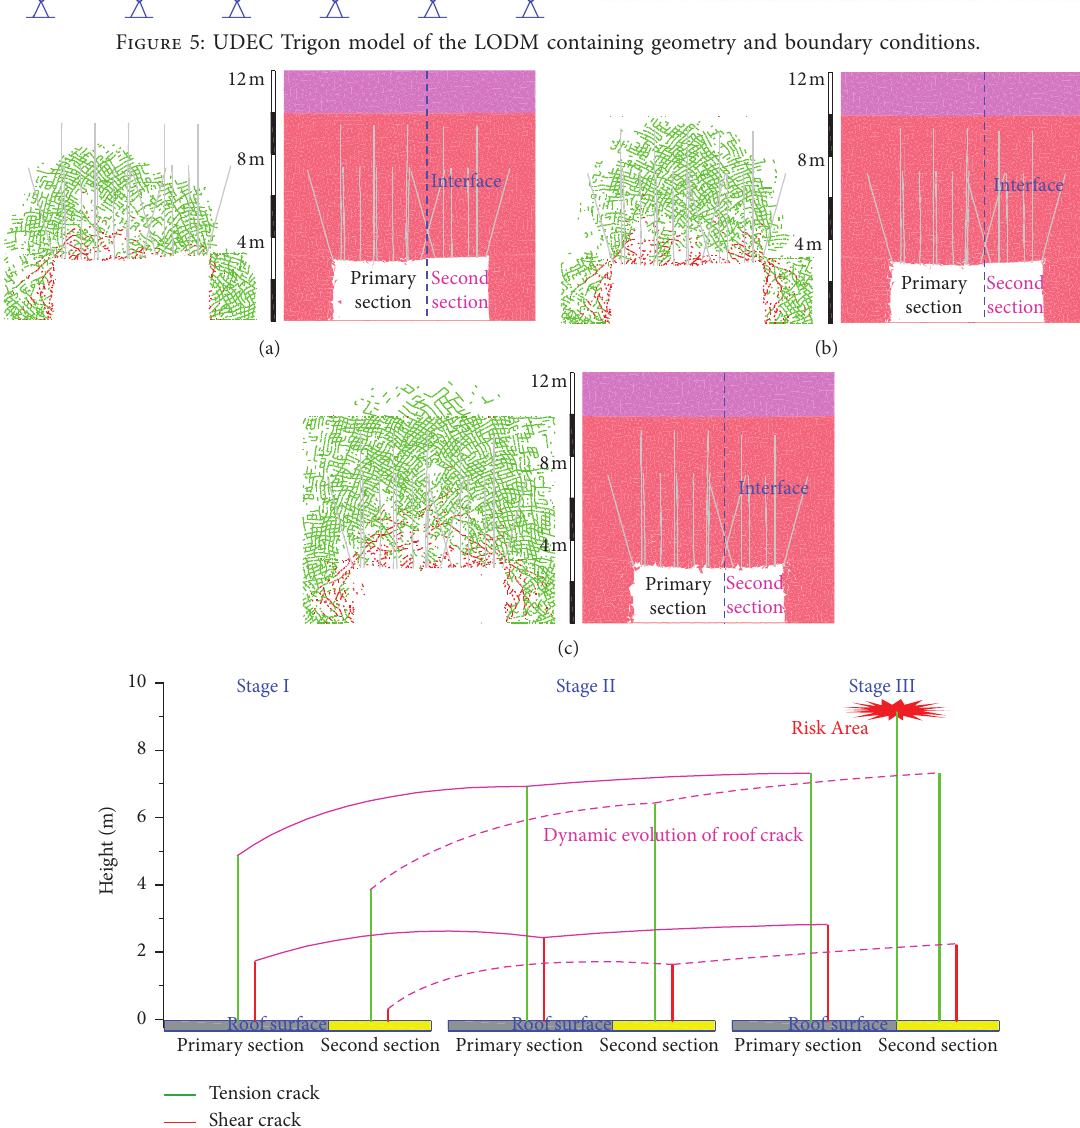
Figure 6: The development process of roof cracks in the full section and failure mode of roof: (a) Stage I; (b) Stage II; (c) Stage III; (d) dynamic evolution of roof crack after second excavation. (The green cracks represent tensile cracks, and the red cracks represent shear